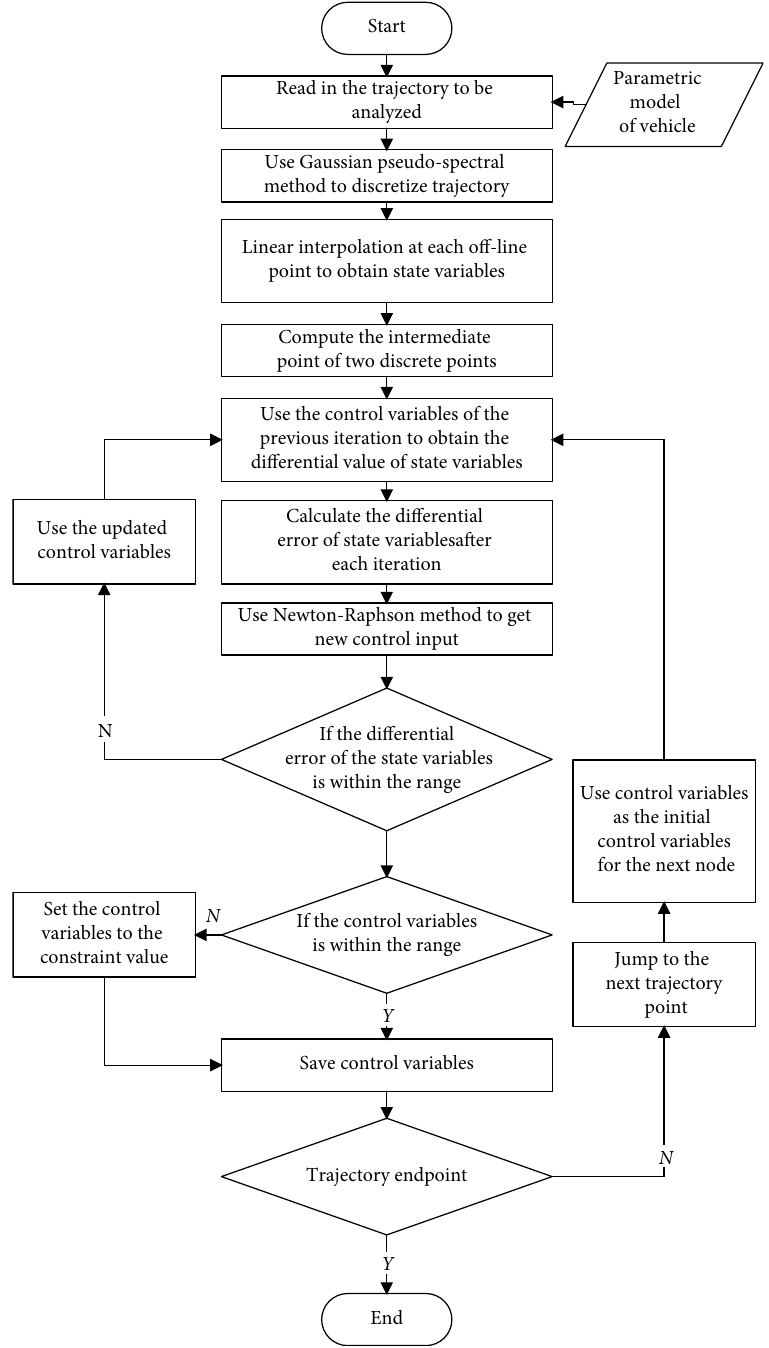
Figure 4: The procedure of the trajectory inverse